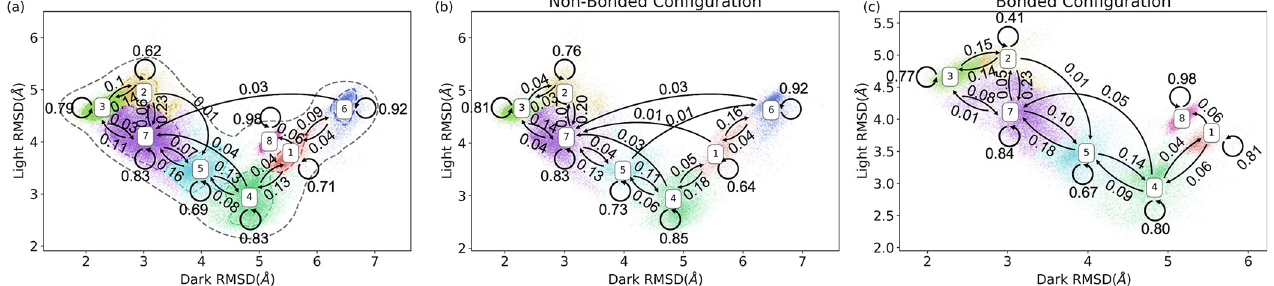
Fig 4. The transition probabilities estimated based on Markov state model among macrostates. (a) The transition probabilities estimated using all trajectories; (b) The transition probabilities estimated using non-bonded trajectories; (c) The transition probabilities estimated using bonded trajectories. State 6 only appears in the non-bonded configurations. State 8 only appears in the bonded configurations. The transition probability among macrostates are significantly different, showing that the formation of photo-induced covalent bond could mediate the kinetics of the system.